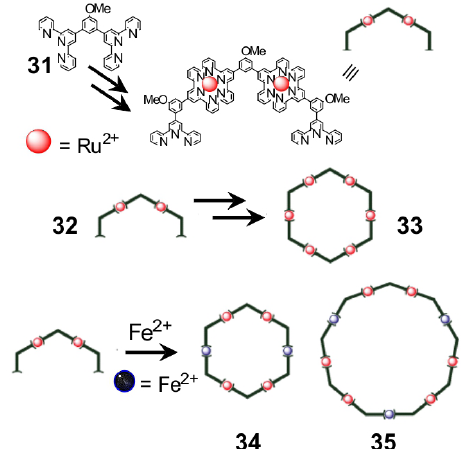
FIGURE 15 – Construction of a trimeric building block facilitated the synthesis of a large, nine-membered ring and homo- and hetero-nuclear hexamers in good yields [Chan, Y.-T.; Li, X.; Yu, J.; Carri, G. A.; Moorefield, C. N.; Newkome, G. R. J. Am. Chem. Soc. , v.133, p.11967-11976, 2011. – Reproduced by permission of The American Chemical Society].